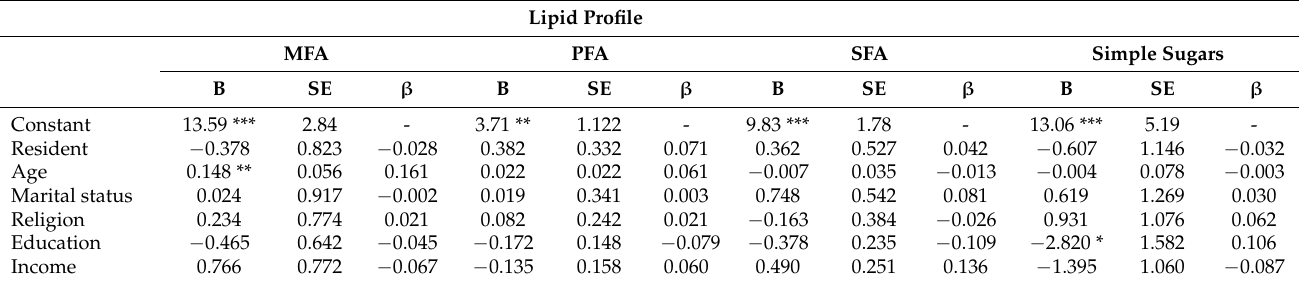
Table 8. Relationship between lipid profile and sociodemographic